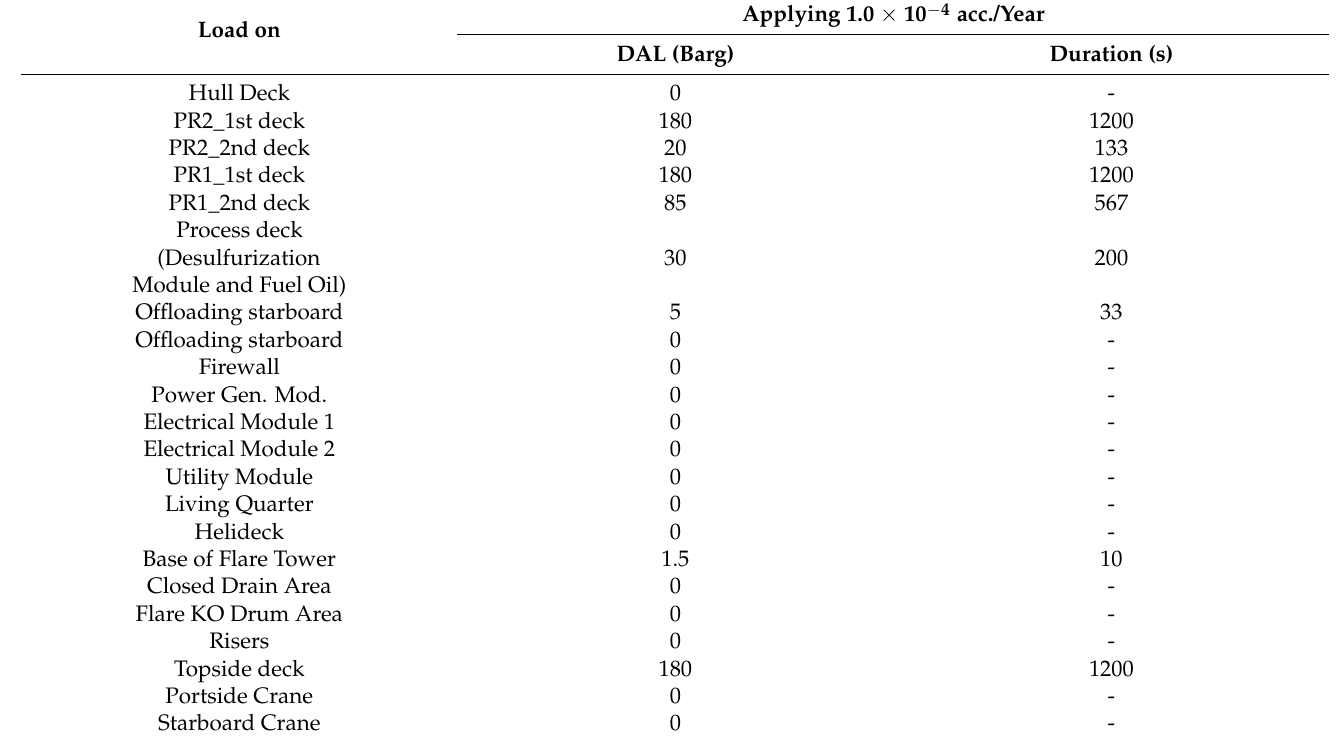
Table 7. Summary of results in terms of the Dimensioning Accidental Loads (DAL) and heat